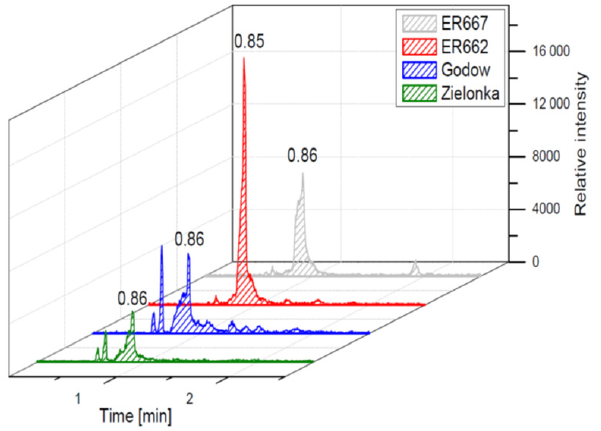
Figure 8. Extracted-ion chromatograms of furanetriol organosulfate with MW 214 from field studies and chamber experiments.